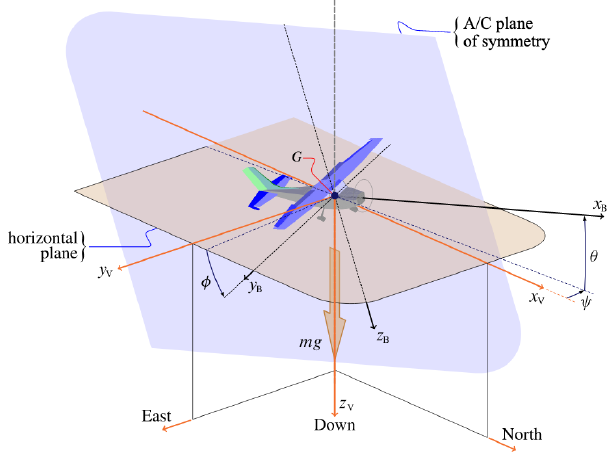
Figure 2. Reference systems. Courtesy of JSBSim